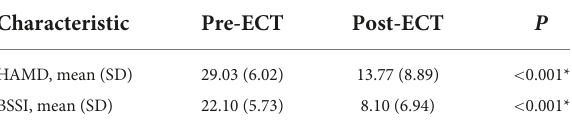
TABLE 2 Comparison of the severity of clinical symptoms between pre- and post-ECT. Characteristic Pre-ECT Post-ECT P